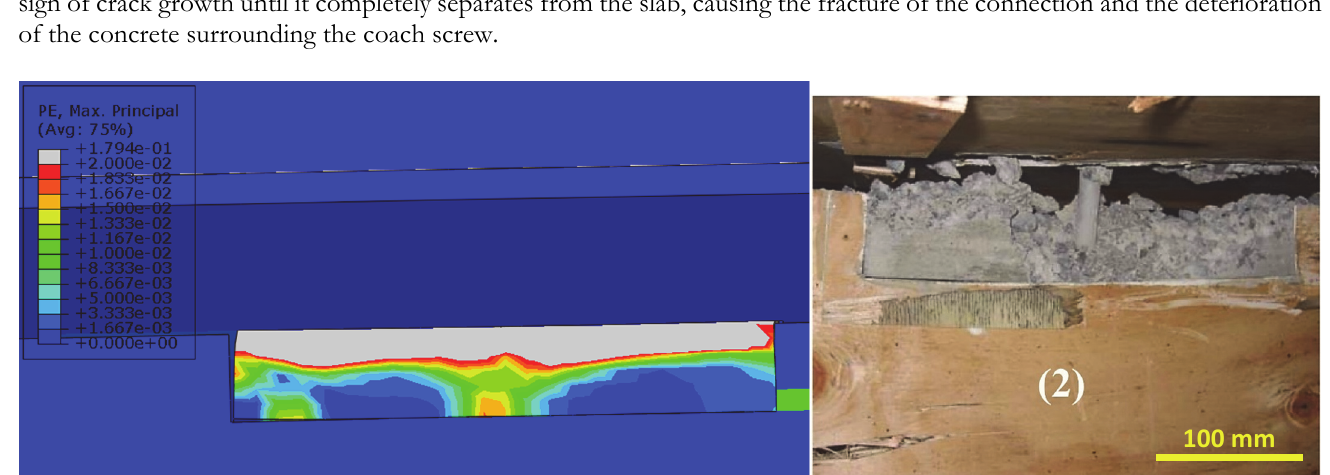
Figure 14: Plastic strain distribution displayed at the notch connection compared to failure mode obtained in the